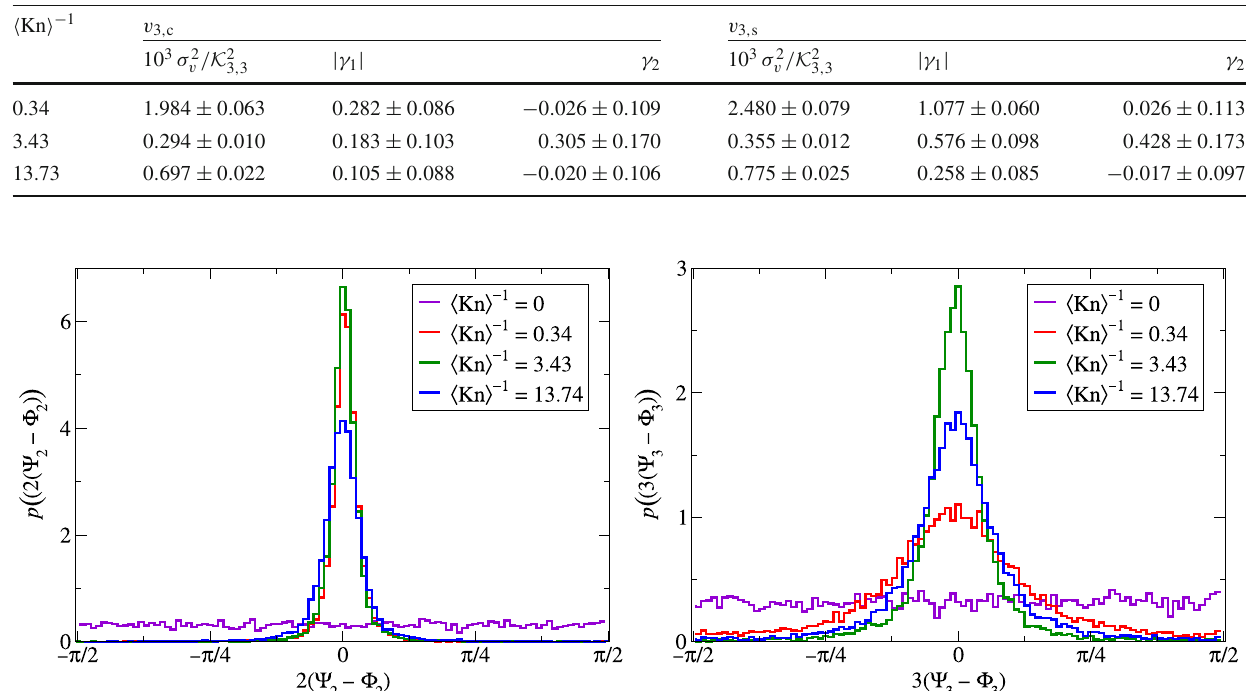
Table 3 Moments of the conditional probability distributions p v | ε (v 3 , c / s | ε 3 , c / s ) of the final-state flow harmonics computed for 10 4 events at b = 6 fm. The variance σ 2 v is divided by the square K 2 of the linear coefficient in relation (4) 3 , 3